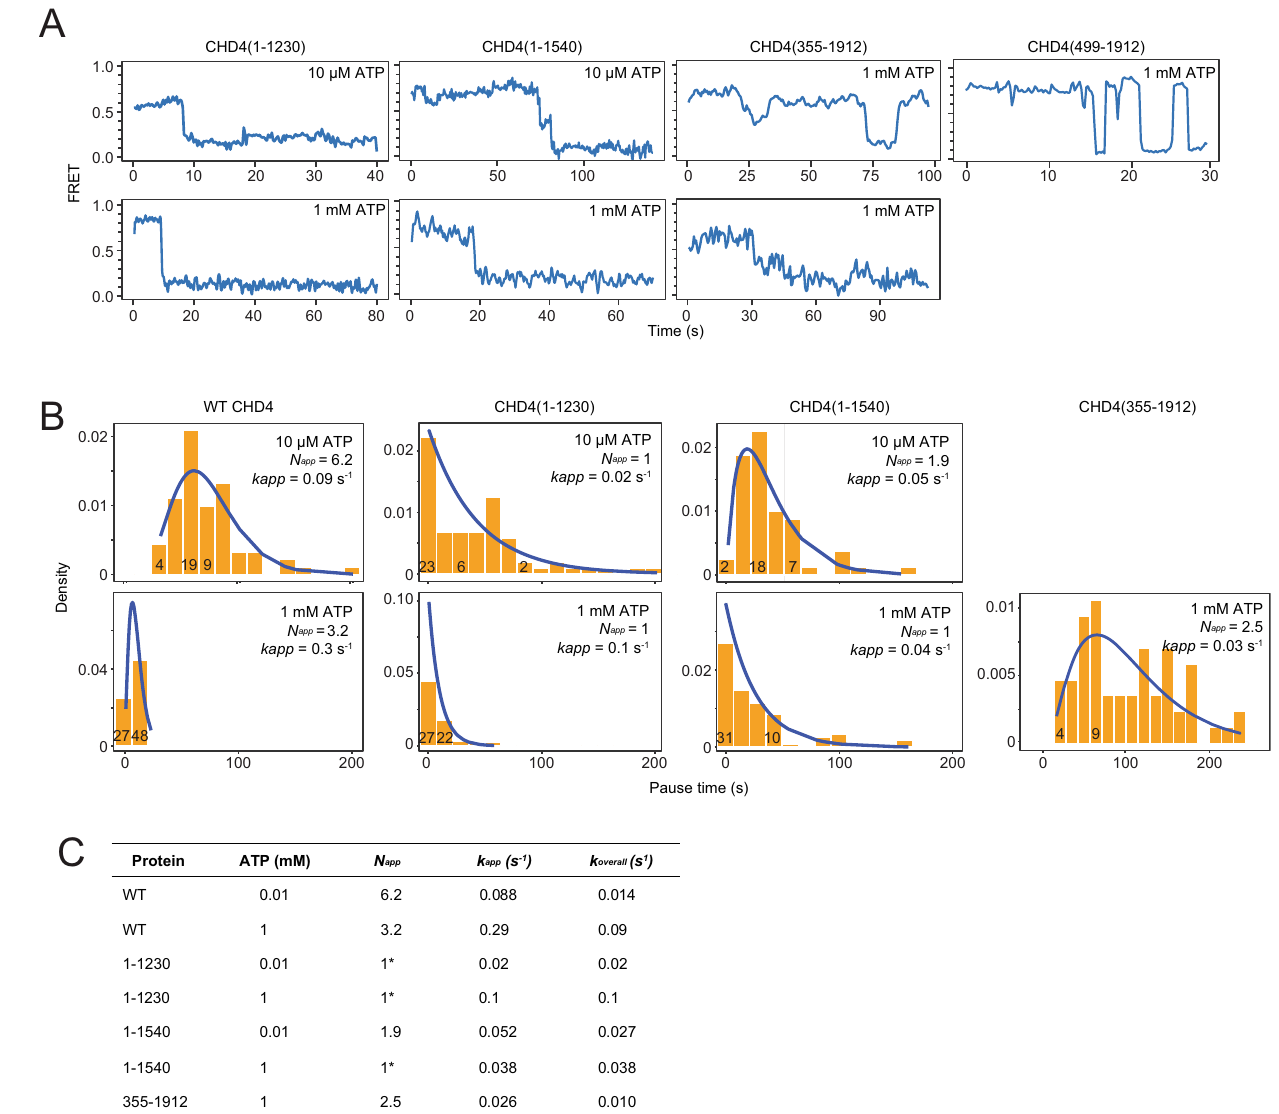
Fig. 7 | smFRET data for CHD4 truncations. A Typical smFRET traces for CHD4 truncations at the indicated ATP concentrations. B Histograms of the pause time at mid-FRET and fi ts in each case to a gamma or exponential function (as appropriate)inwhichthenumberofequivalentstepsandthepseudo- fi rst-order rate constant are fi tted parameters. C Table summarizing parameters obtained